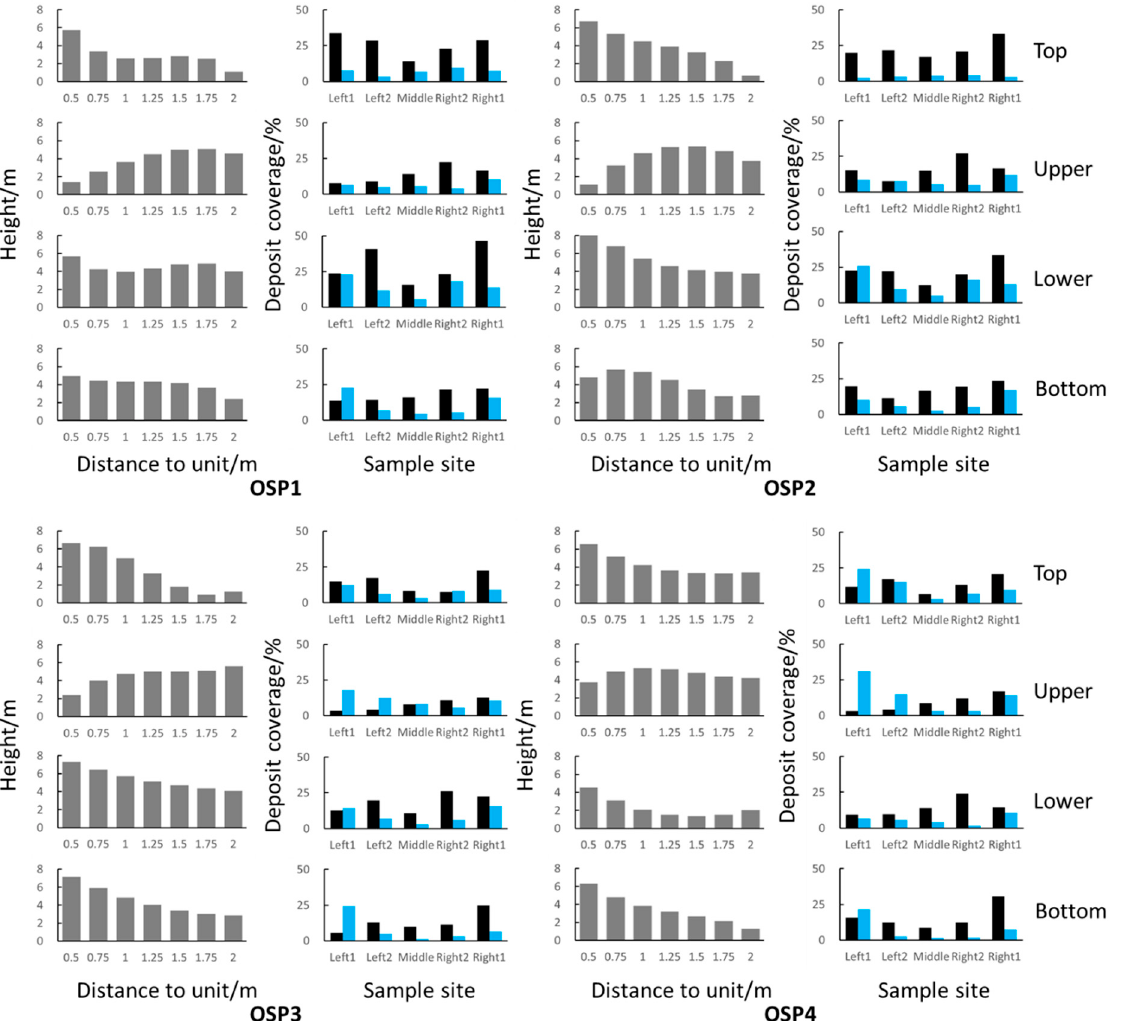
Figure 4. The airflow distribution at different distances from the MAS (left), CAD (black block), and CAB (blue block) of samples in all layers (right) of OSP1–OSP4. OSC1–OSC3 shared a similar airflow velocity distribution pattern just like OSP1. OSP3, OSC2, and OSC3 have higher air velocities than OSC1 at Middle height, which made the CAB of OSC1 less than OSC2 and OSC3 at the same height. OSC3 has a higher airflow velocity at Middle height compared to OSC6, and OSC5 also has a higher airflow velocity at Top height compared to OSC4, however in the corresponding layers OSC6 has a similar CAB to OSC3 and OSC4 to OSC5. In addition, the OSC5 has a higher air velocity at Top height as well as a CAB compared to the OSC6 (see Figure 5).